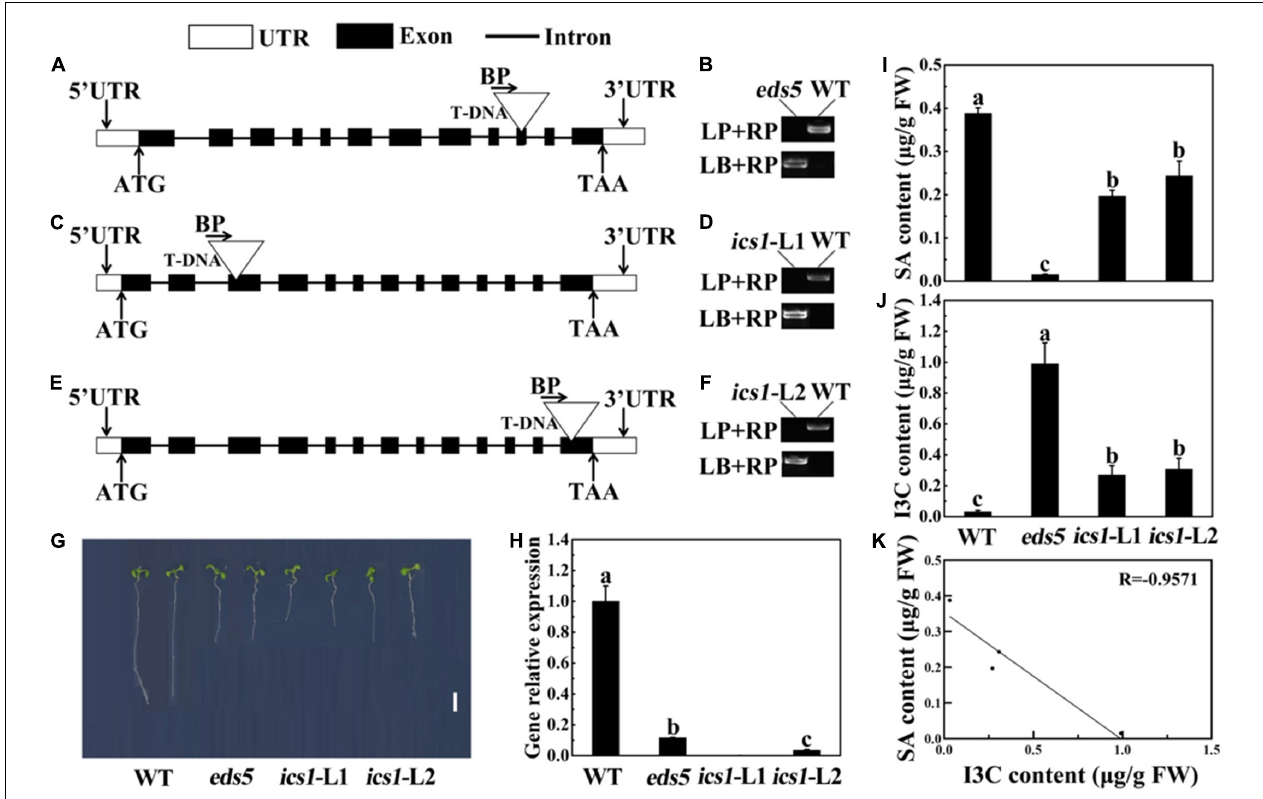
FIGURE 6 | Verification of SA mutants in Arabidopsis thaliana . (A,C,E) Schematic representation of the eds5 (A) , ics1-l1 (C) , and ics1-l2 (E) gene showing the insertion location of T-NDA. (B,D,F) Verification of homozygosity in Arabidopsis thaliana mutants. LP, left genomic primer; RP, right genomic primer; BP, T-DNA border primer; LB, the left T-DNA border primer. (G) Phenotype of seedlings grown for 7 days. Bar = 0.5 cm. (H) Expression levels of related genes in Arabidopsis thaliana wild-type and mutants. (I) SA content in wild type and mutant. (J) I3C content in wild type and mutant. (K) Correlation analysis between SA content and I3C content in Arabidopsis thaliana . Data represented as means ± SD from three independent experiments. Different letters indicated statistical differences ( P <